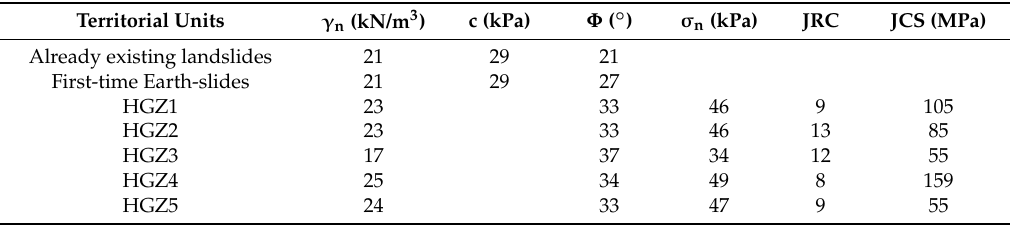
Table 1. Geomechanical parameters. γ n is the total weight for unit volume, c is the cohesion, Φ is the friction angle, n is the normal stress acting on joint, JRC is the Joint Roughness Coefficient and the JCS the Joint Compressive Strength parameter [31]. The HGZ are referred to Figure 5.